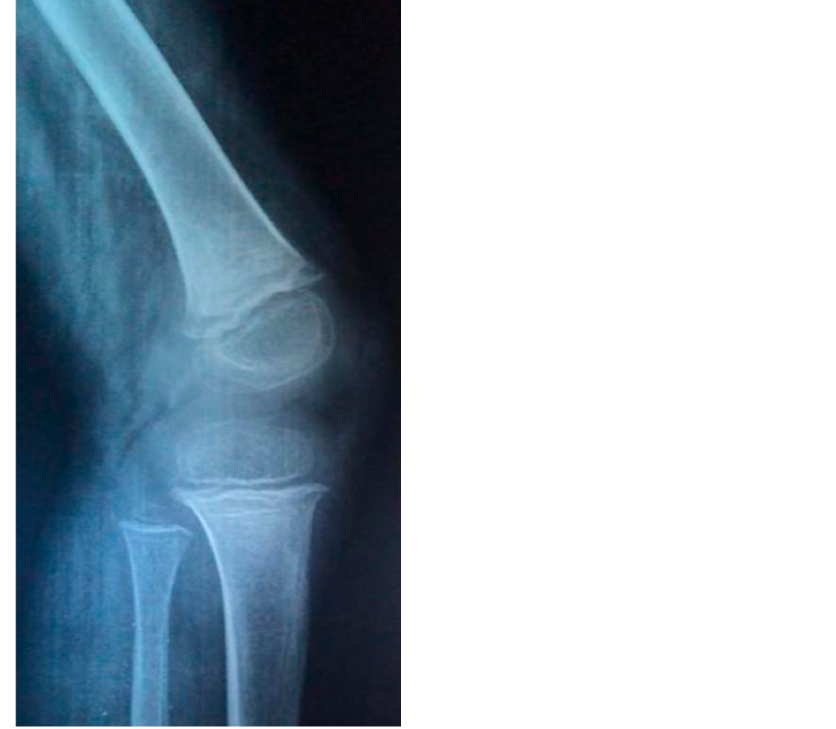
Figure 3. Oral tissues healing presentation after four weeks of Vitamin C administration (Tf). 3. Materials and Methods A systematic review of the literature was performed through PubMed, ISI Web of science, and Cochrane Library. “Scurvy”, “vitamin C deficiency”, “Moeller’s disease”, “Cheadle's disease”, “scorbutus”, “Barlow's disease”, “hypoascorbemia”, “lack of vitamin